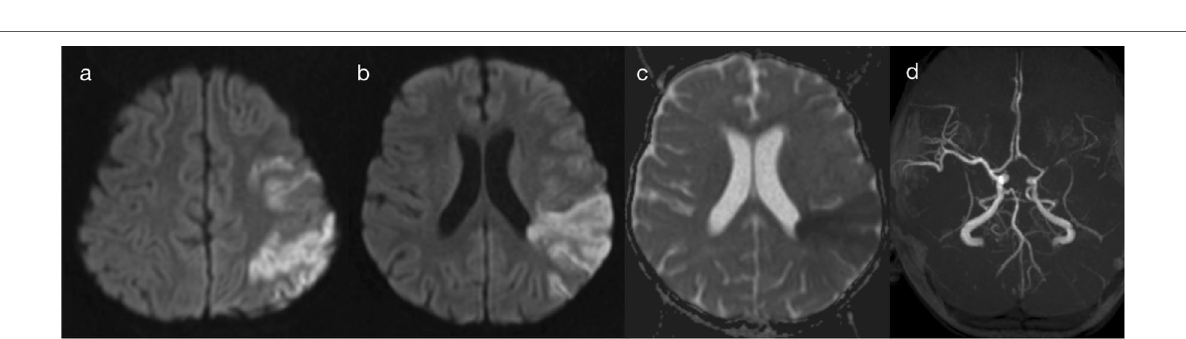
Fig. 8 Restricted diffusion in supratentorial grey matter—vascular territory infarct (Pattern 2C). 4‑year‑old child with 2 weeks of malaise, followed by decreased conscious state and right arm weakness. CSF was positive for tuberculosis (TB). DWI ( a , b ) and ADC map ( c ) were consistent with an acute infarct involving the left frontoparietal lobes. MR angiography ( d ) demonstrated left middle cerebral